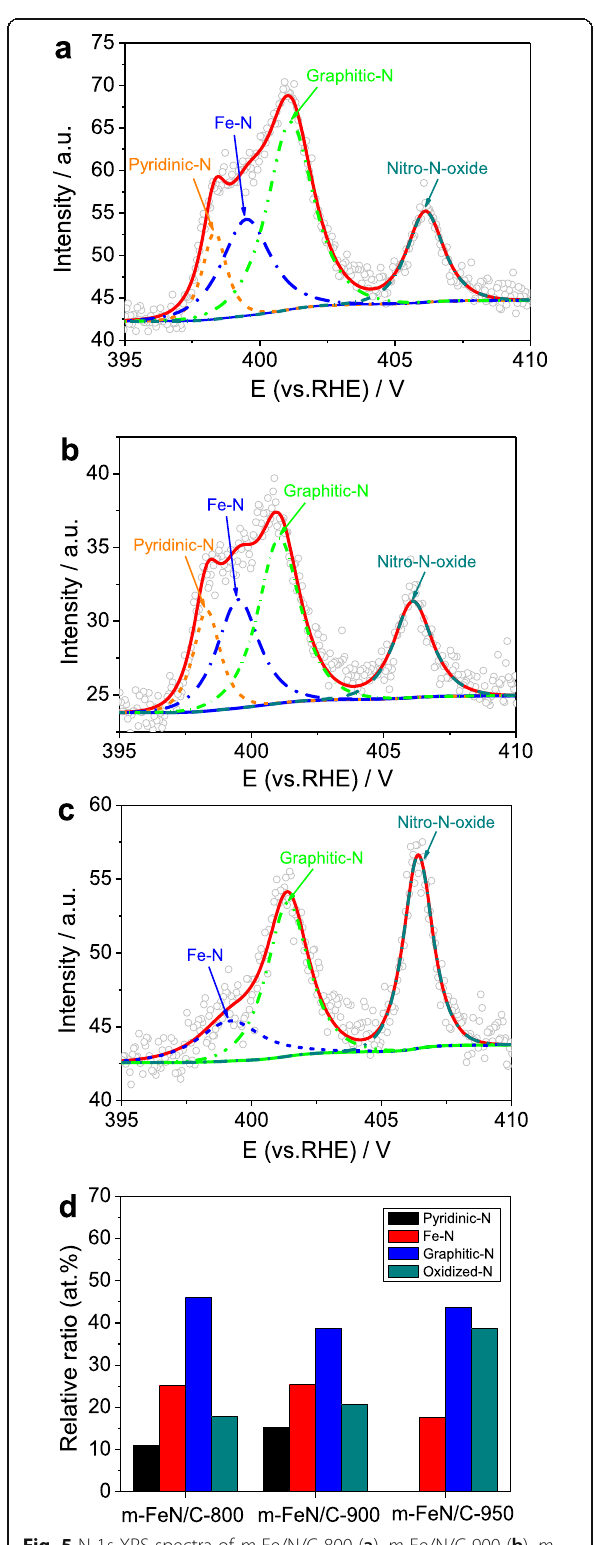
Fig. 5 N 1 s XPS spectra of m -Fe/N/C-800 ( a ), m -Fe/N/C-900 ( b ), m - Fe/N/C-950 ( c ), and their relative contents in total N content ( d